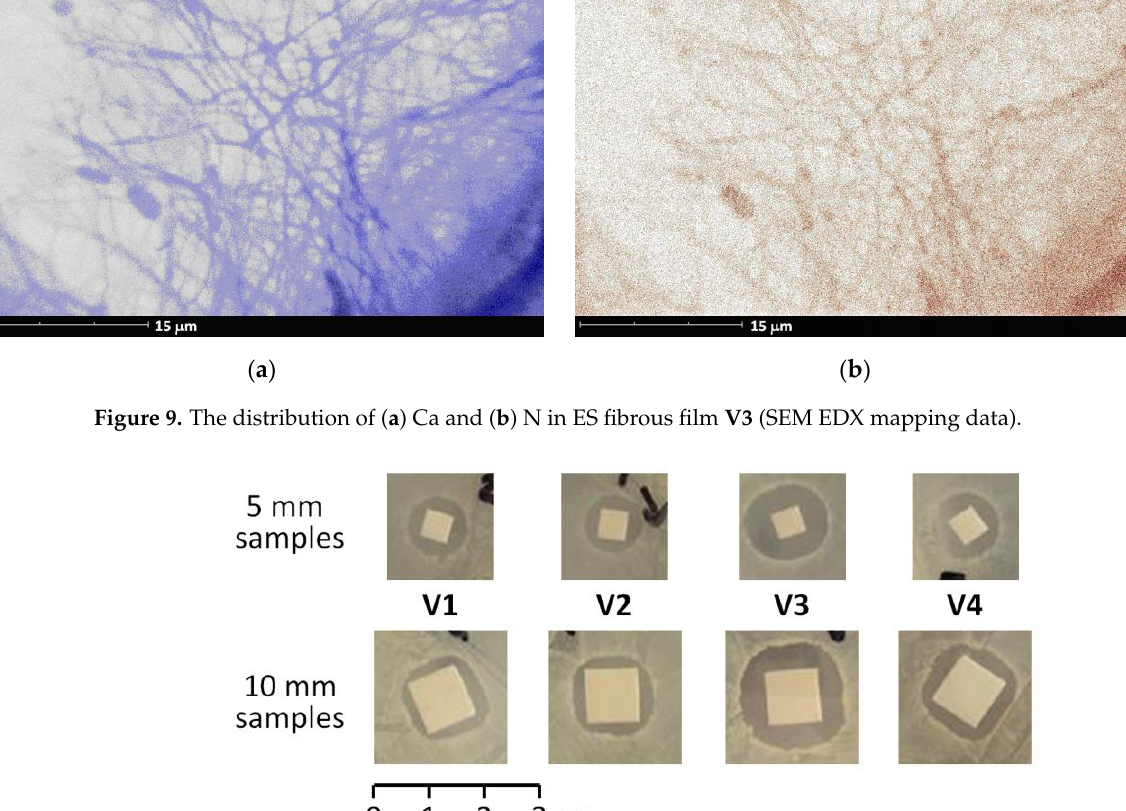
Figure 9. The distribution of ( a ) Ca and ( b ) N in ES fibrous film V3 (SEM EDX mapping data).